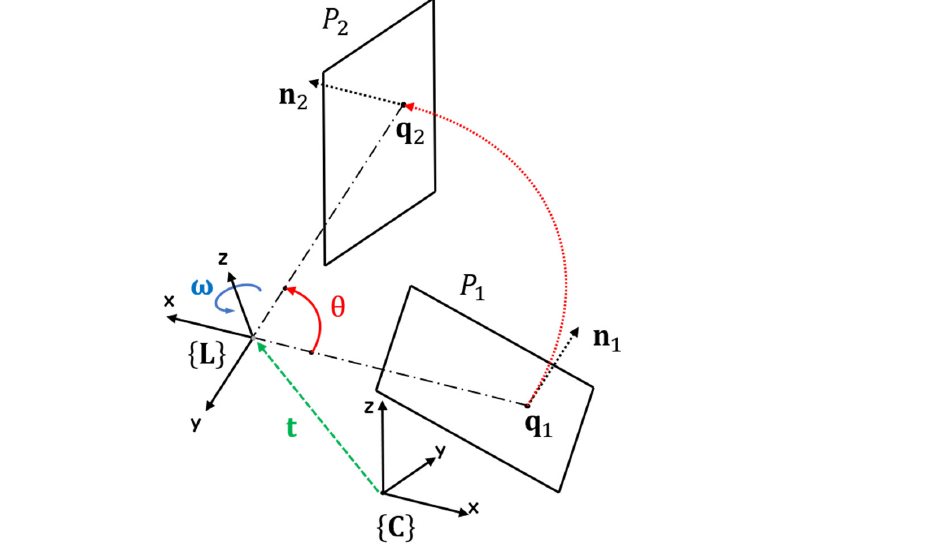
Figure 8. The shape and trajectory of the plane rotating by θ along arbitrary axis (red).